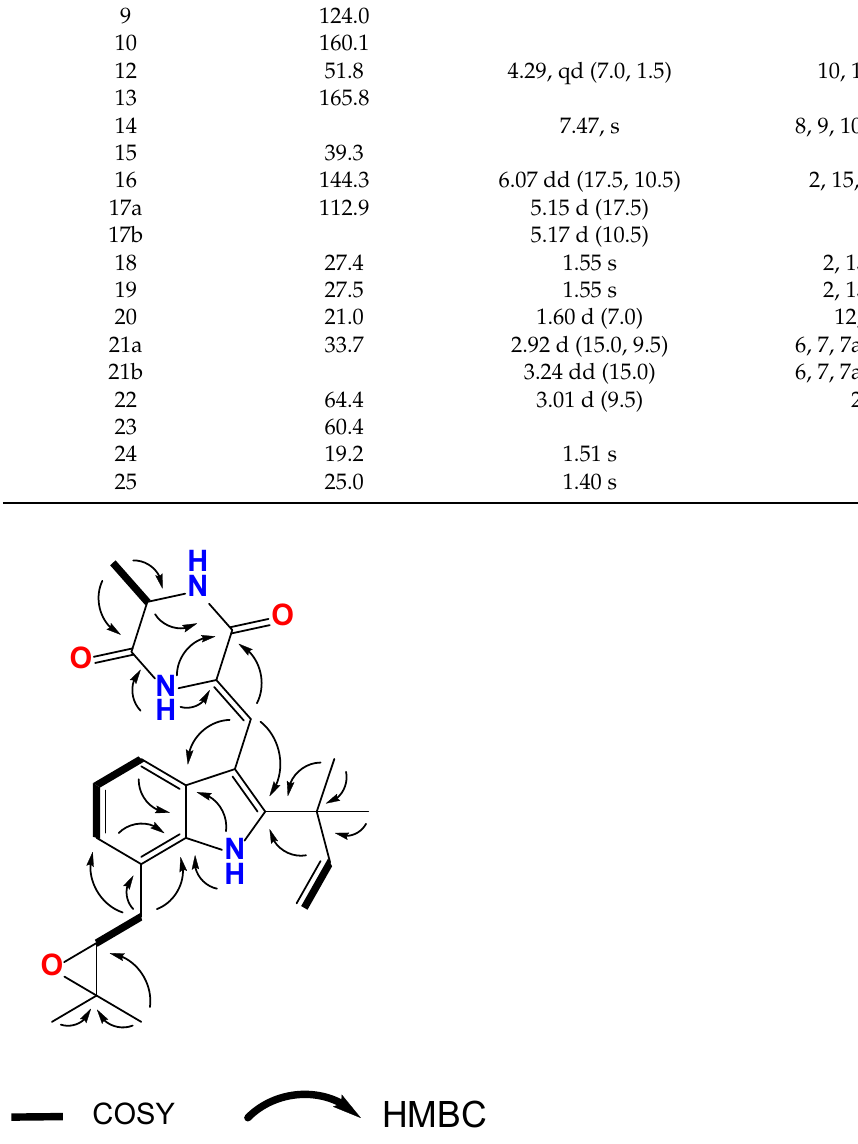
Figure 8. Key 1 H- 1 H COSY and HMBC correlations for compound 1 .